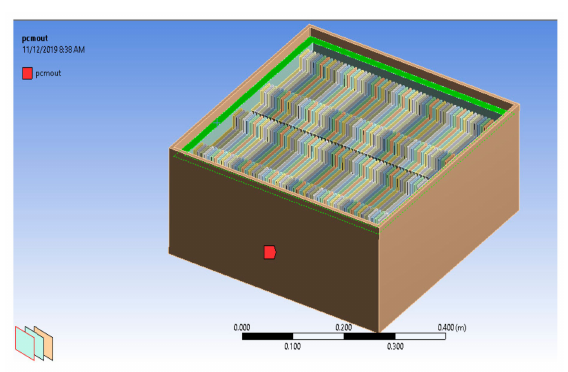
Figure 6. Modelling of the proposed 6-kW Li polymer battery module.